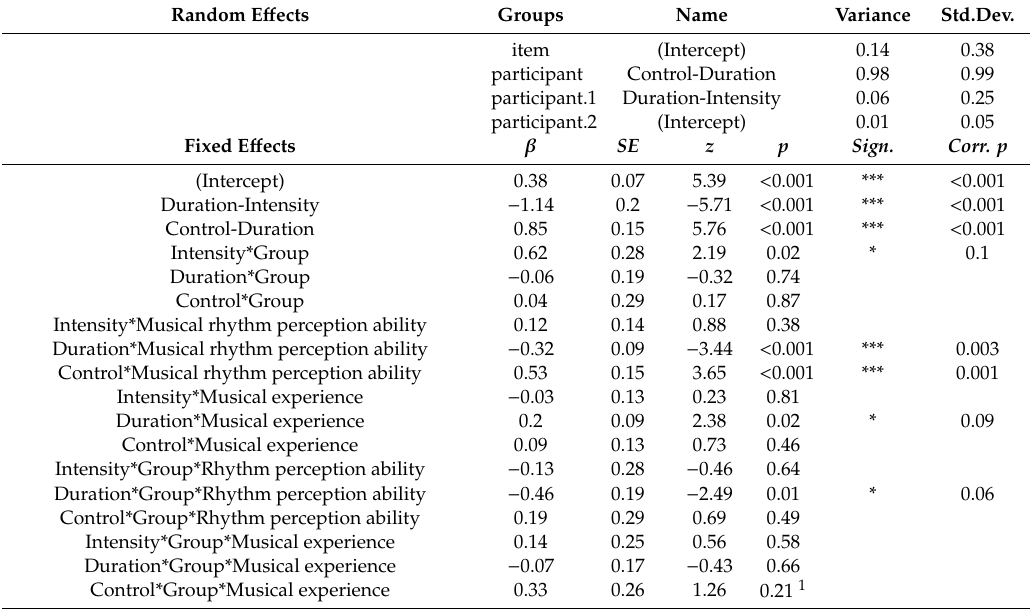
Table A9. Output of the fifth model that extends model 3 by musical experience as control variable, which did not improve the model fit.